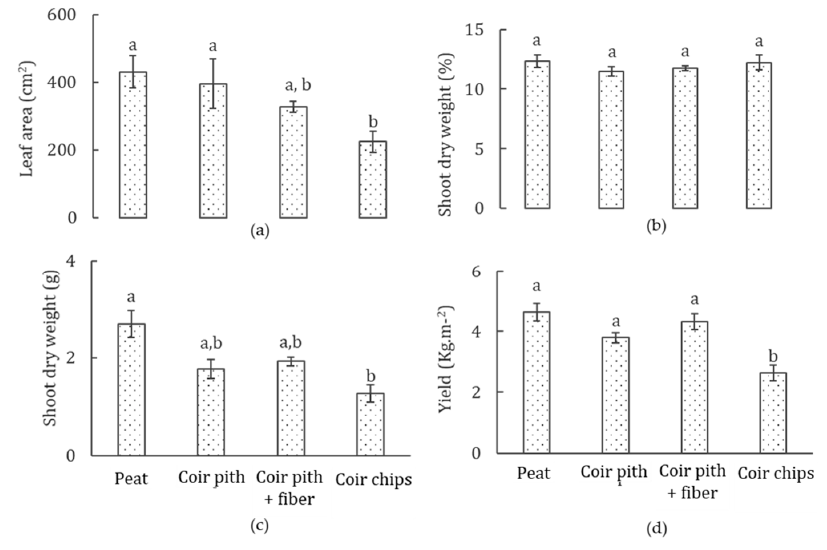
Figure 2. Leaf area ( a ), shoot dry weight (%) ( b ), shoot dry weight per plant ( c ), and fresh yield ( d ) of spinach. Means with different letters are significantly different at p < 0.05. Each bar represents the mean of five replicates, and the error bars represent ± 1SE.